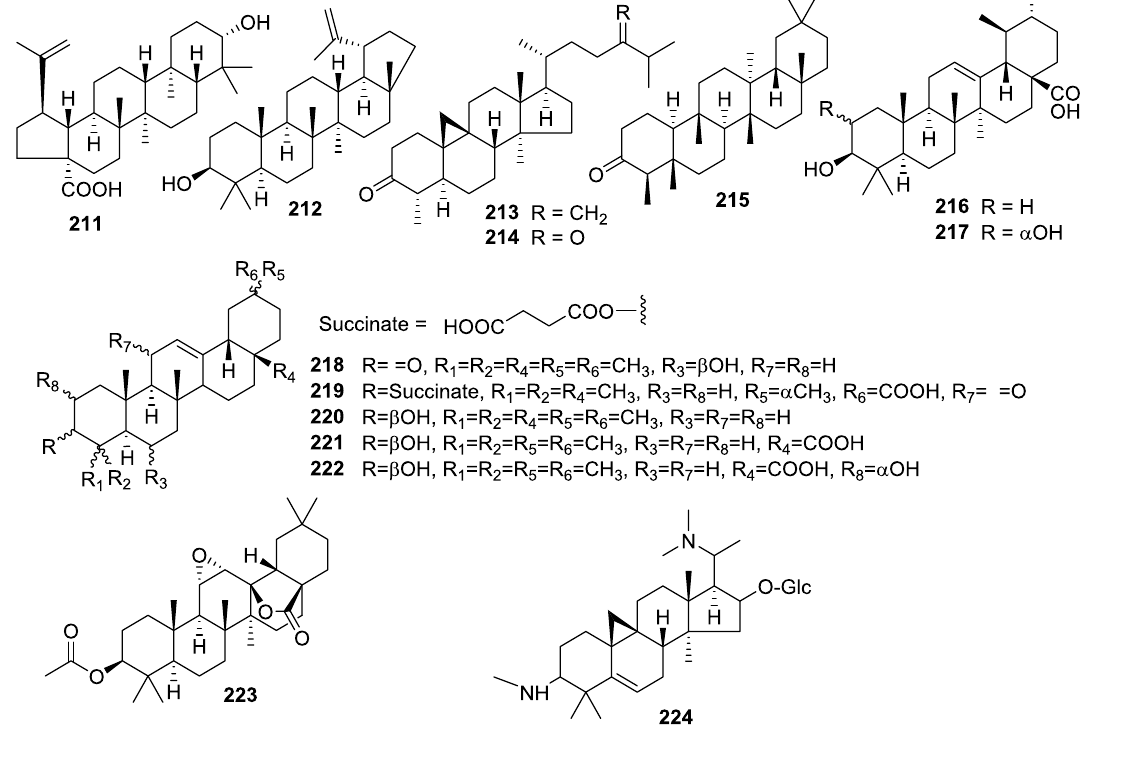
Fig. 4 Triterpenoids 211 – 224 from